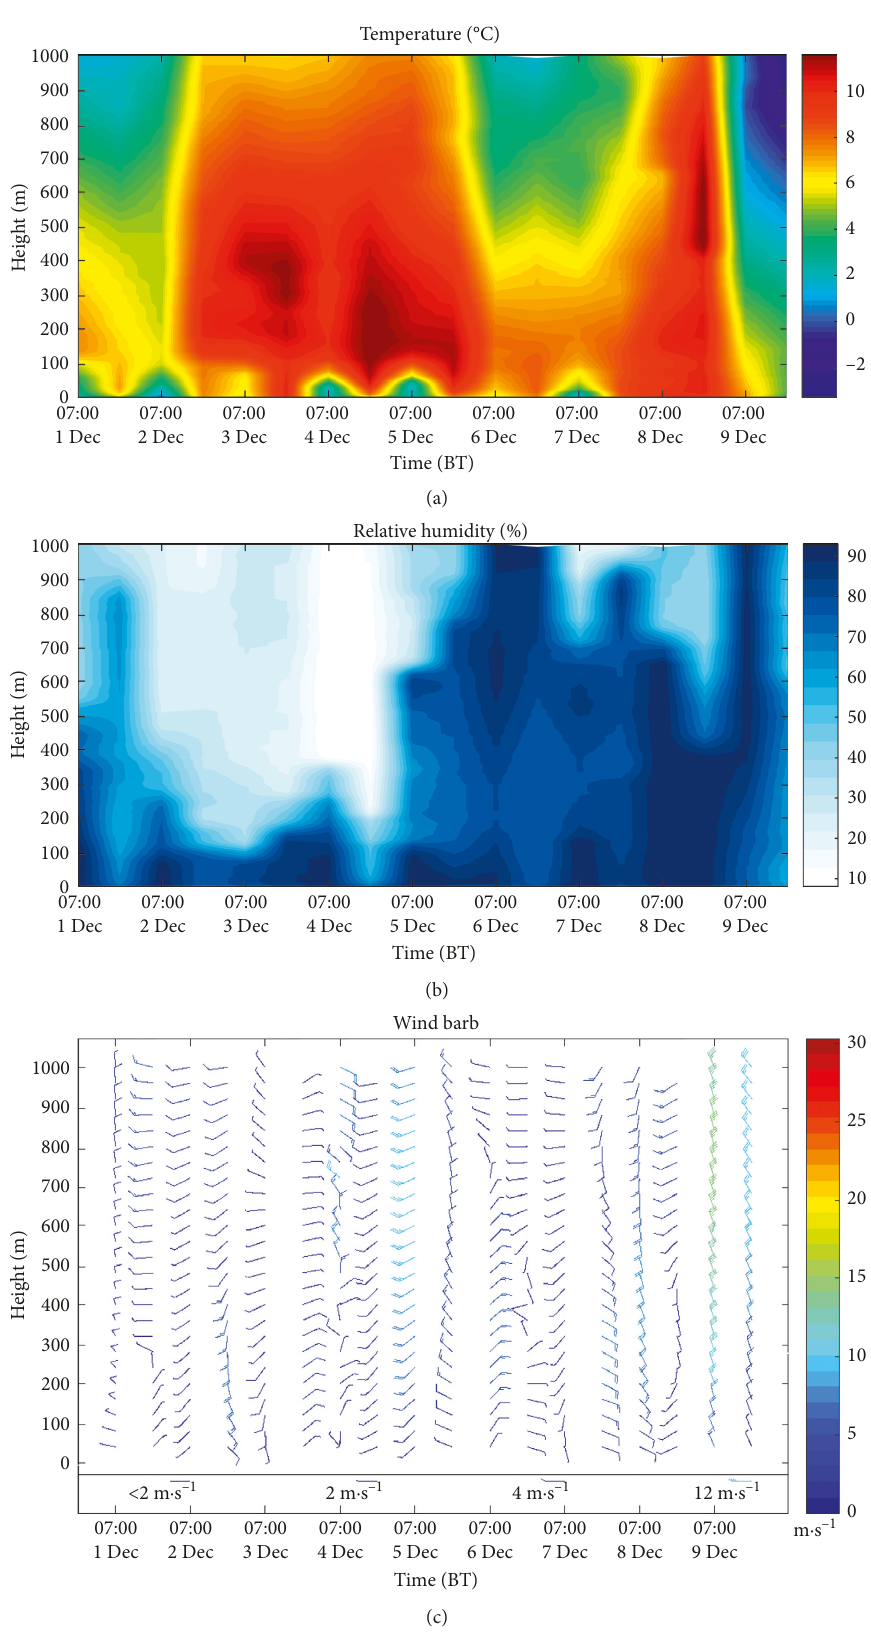
Figure 8: Time-height profile of (a) temperature, (b) relative humidity, and (c) wind barb at the Sheyang site from 07:00 BTon 1 December to 19:00 BT on 9 December